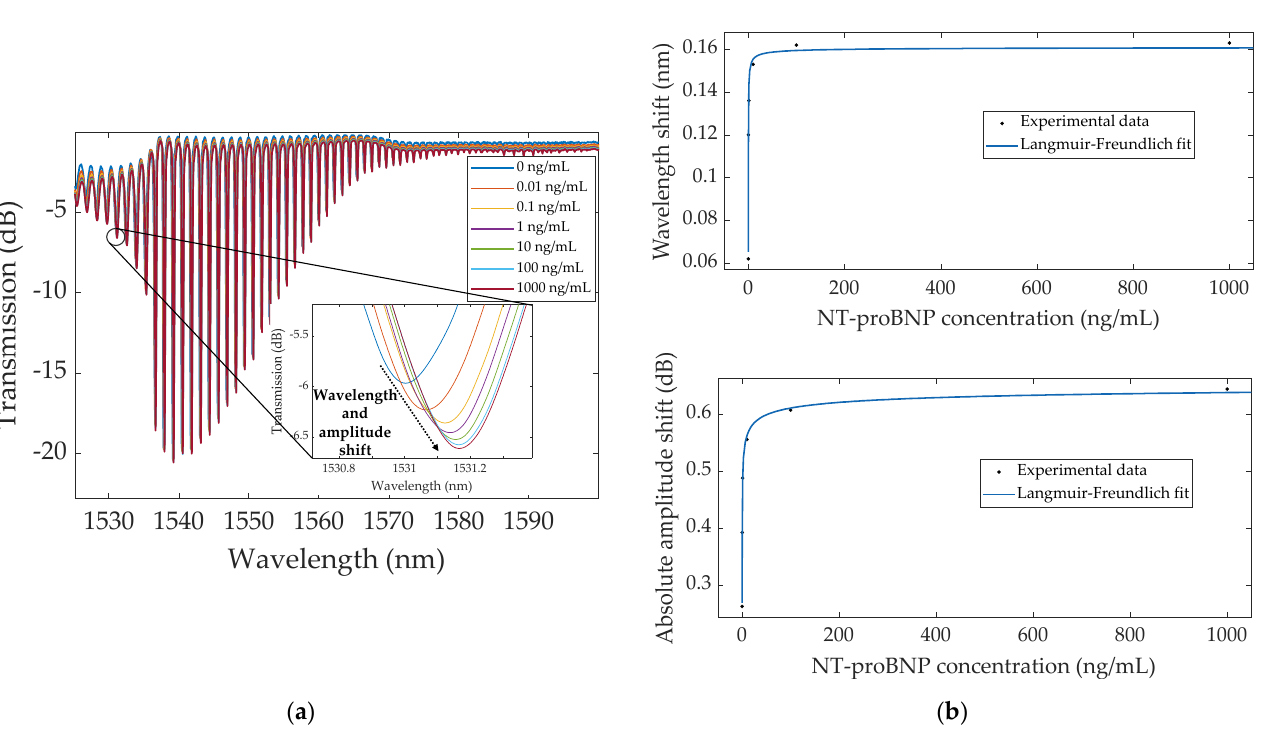
Figure 5. ( a ) Spectral evolution of the biofunctionalized bare TFBG, in PBS, before (0 ng/mL) and after incubation in each concentration of NT-proBNP (0.01–1000 ng/mL), zooming in on the most sensitive mode around 1531 nm; ( b ) Wavelength (top) and absolute amplitude (bottom) variations with concentration, showing the Langmuir–Freundlich fit to the experimental data.